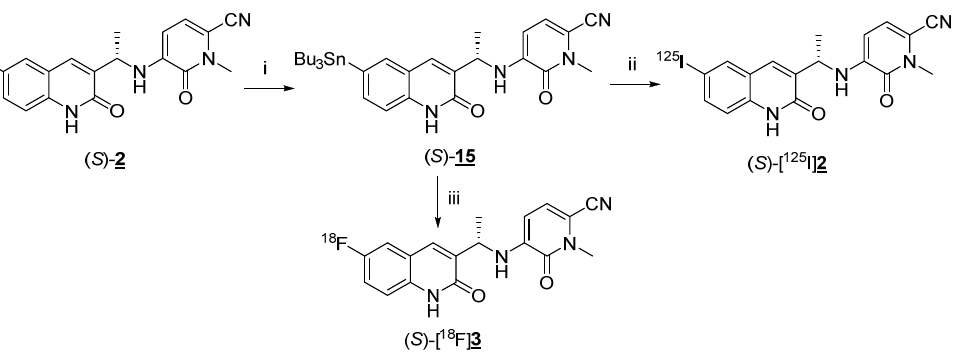
Figure 6. ( A ): UV-HPLC chromatograms (330 nm) of iodinated and fluorinated reference com- pounds ( S )- 2 and ( S )- 3 ; ( B ): radioactivity-HPLC chromatograms of the corresponding radiotracers ( S )-[ 125 I] 2 and ( S )-[ 18 F] 3 obtained after semipreparative RP-HPLC purification and formulation. The radioactivity detector was connected in series after the UV detector, which accounts for the slight difference of retention times ( ≈ 0.3 min) observed between 125 I/ 127 I or 18 F/ 19 F products. In the ethanolic solution eluted after the C18 SPE cartridge, as well as in the formulation medium and in Dulbecco’s Phosphate Buffered Saline (DPBS, pH 7.4), the radiotracer was found to be stable over hours at room temperature (RCP: 98.0%, 97.2%, and 97.4%, respectively, at 3 h post formulation, Figure 7). In addition, no significant degradation or deiodination of the radiotracer ( S )-[ 125 I] 2 was detected in mouse serum after incubation for 3 h at 37 °C (RCP: 94.3%).